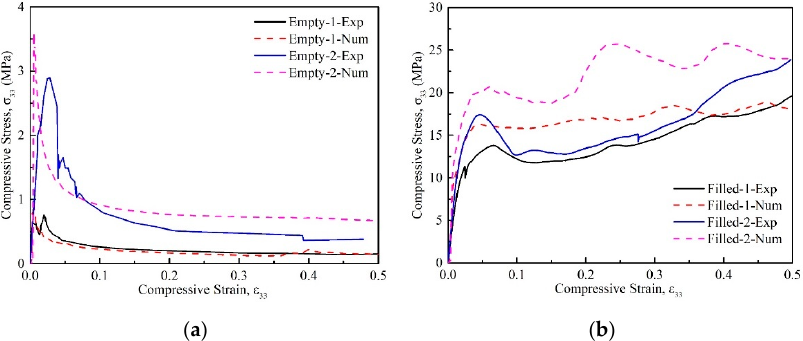
Figure 4. Measured and simulated compressive stress–strain curves of the Y-shape cored sandwich panels. ( a ) Empty panel; ( b ) aluminum foam-filled panel.